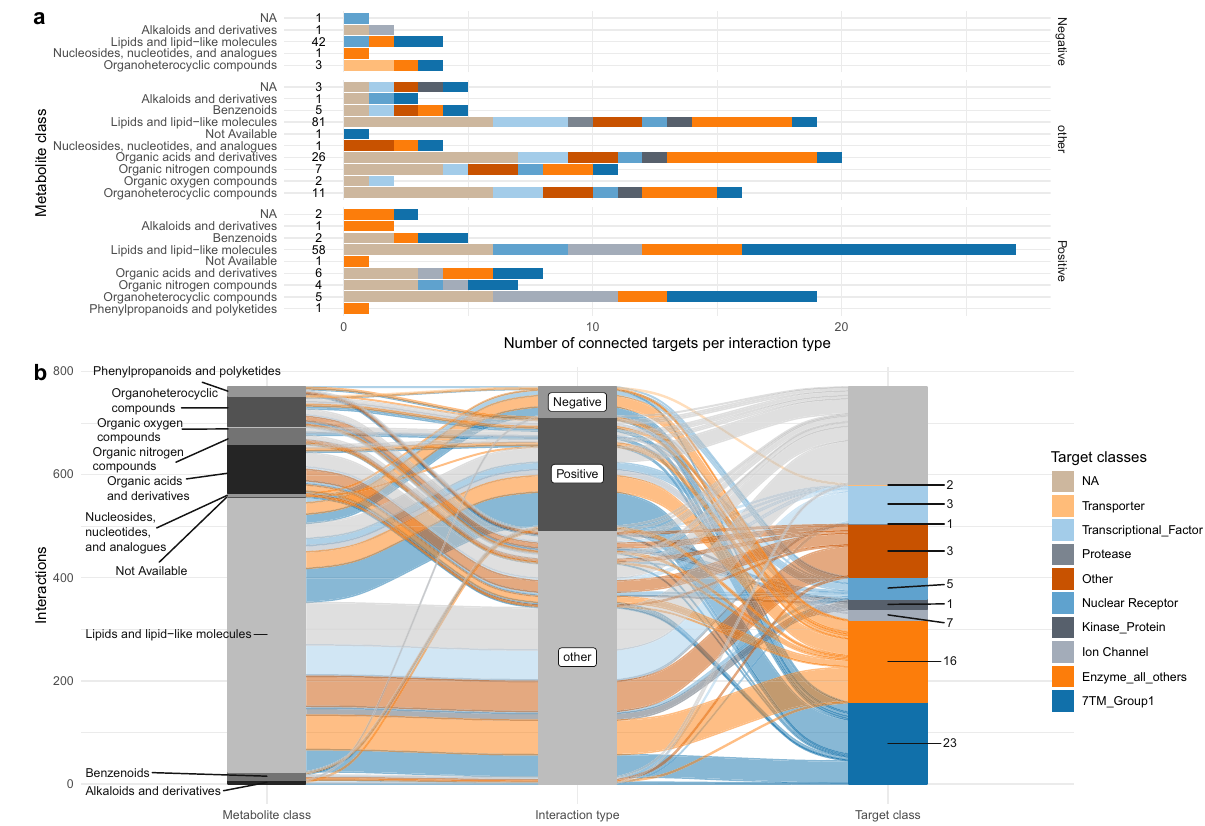
Fig. 2 Overview of the connected metabolites with highest ranking scores and the perspective targets. a Distribution of target drug classes per each metabolite class (numbers represent unique metabolites per metabolite class). b Alluvial plot describing the distribution of connections between metabolite classes, modulation type and drug target classes (numbers represent unique targets per drug target